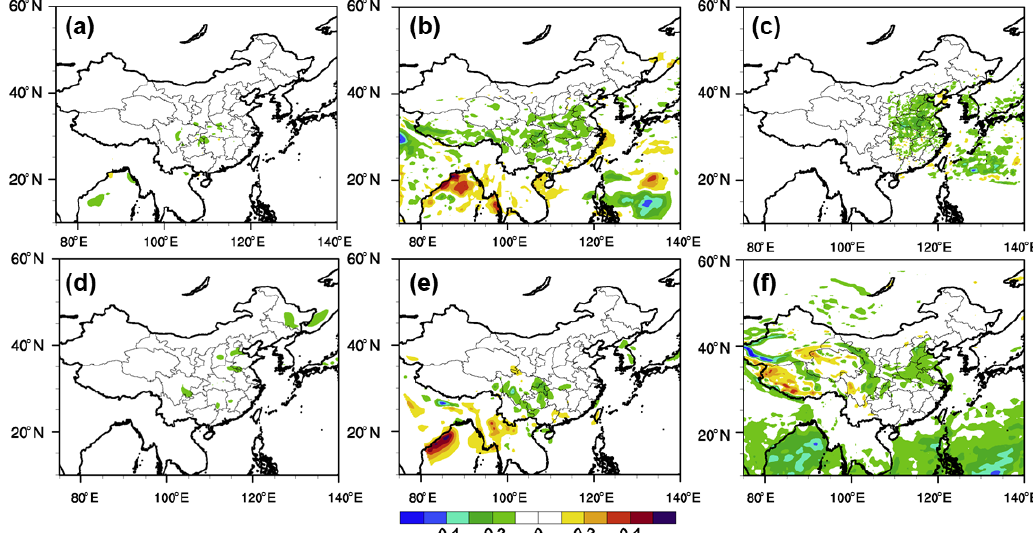
Figure 5. Monthly (January 2010) mean changes in wind speeds at 10m (WS10, ms − 1 ) due to aerosol radiative effects from M1 (a) , M2 (b) , M4 (c) , M5 (d) , M6 (e) , and M7 (f) (M1: Pusan National University; M2: University of Iowa; M4: NASA; M5: Institute of Atmospheric Physics; M6: Nanjing University; M7: University of Tennessee; Gao et al.,